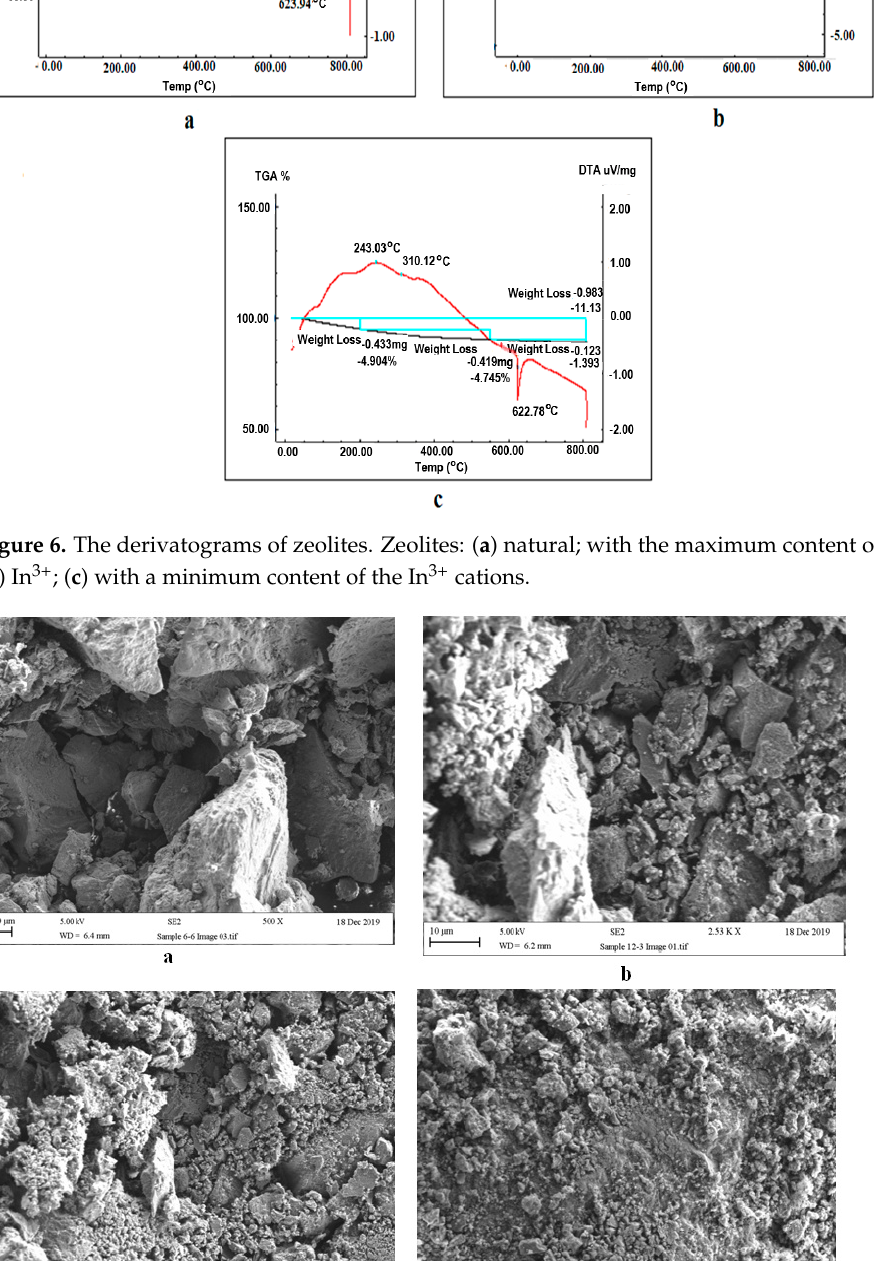
Crystals 2022 , 12 , x FOR PEER REVIEW